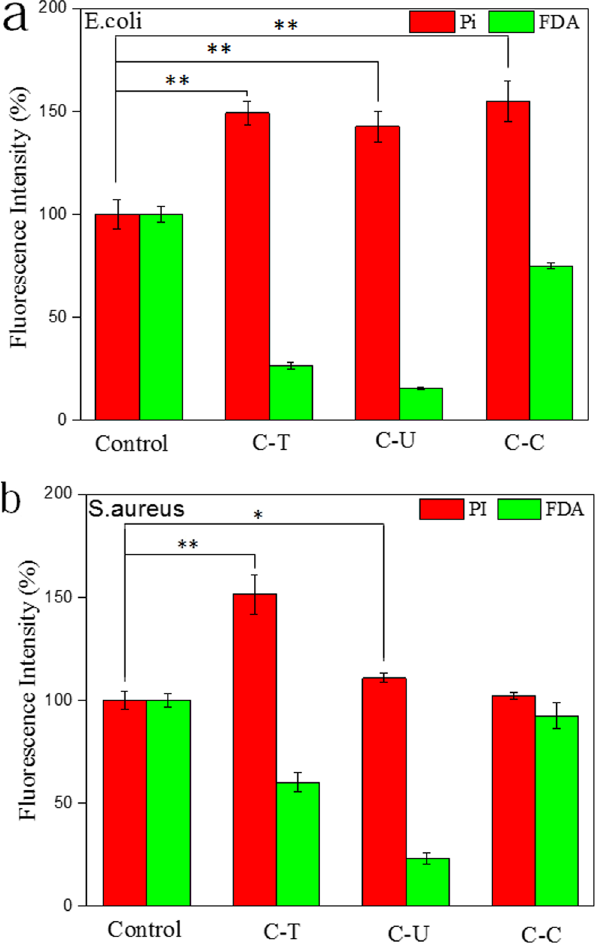
Figure 8. Fluorescence microplate reader analysis of membrane permeability. ( a ) Staining of E. coli using Pi and FDA ( b ) staining of S. aureus using Pi and FDA; 0.4 mL inoculum containing ~1.5 × 10 6 CFU/mL of either E. coli or S. aureus were incubated in each well (96-well plate) at 37 °C for 24 h. Identical concentration of chitosan (1 mg/mL) was added to each well. Eight wells were measured from each test group, ** p < 0.01, * p <